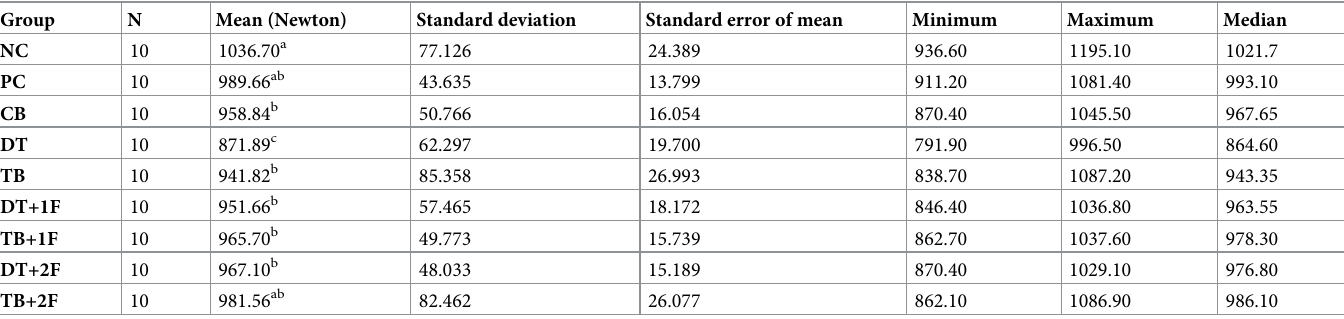
Table 1. Mean values of the groups in N and descriptive statistics of the analyses.